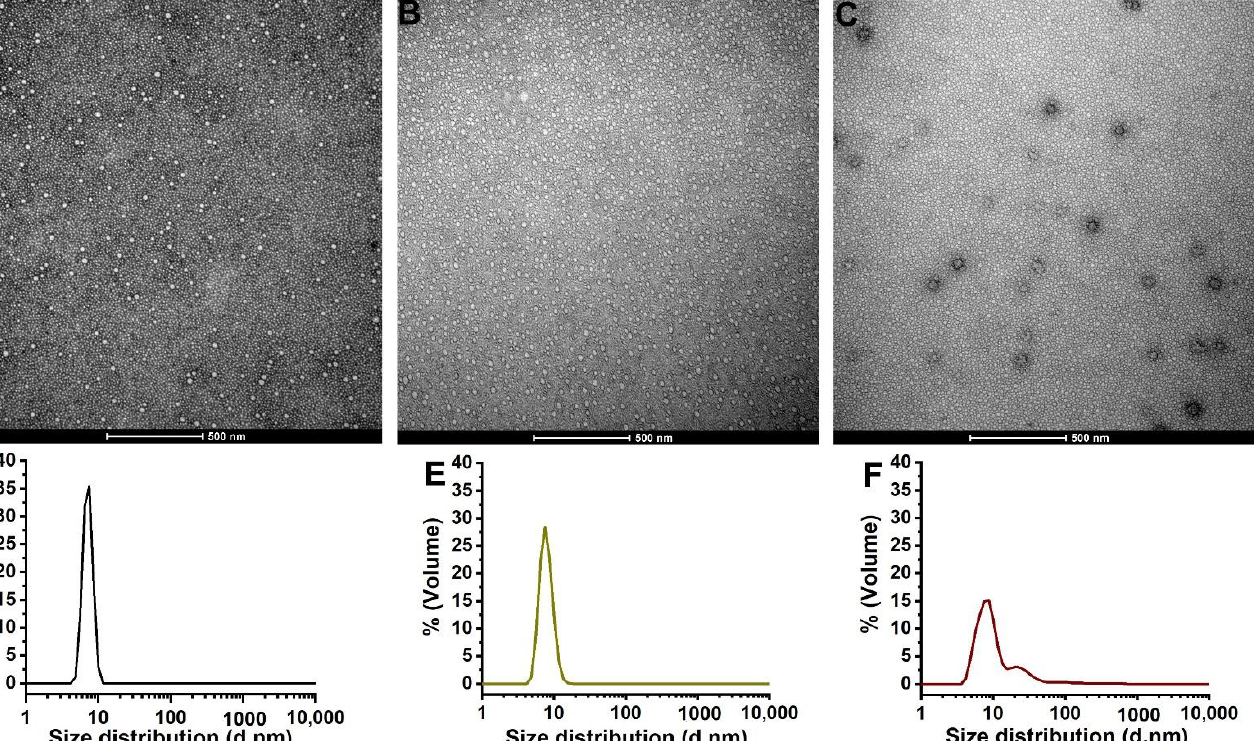
Figure 1. Representative images obtained by TEM ( A – C ) and distribution percentage by volume graphs of the micelles analyzed by DLS ( D – F ). The images and graphics are, respectively, from the following samples: ( A , D ) micelles formed in Pluronic ® F127 solution in water; ( B , E ) micelles formed from the hydrogel solution without VADE; and ( C , F ) micelles formed from VADE-loaded-hydrogel (1:10). The experiment was performed once and in triplicate. Scales bar = 500